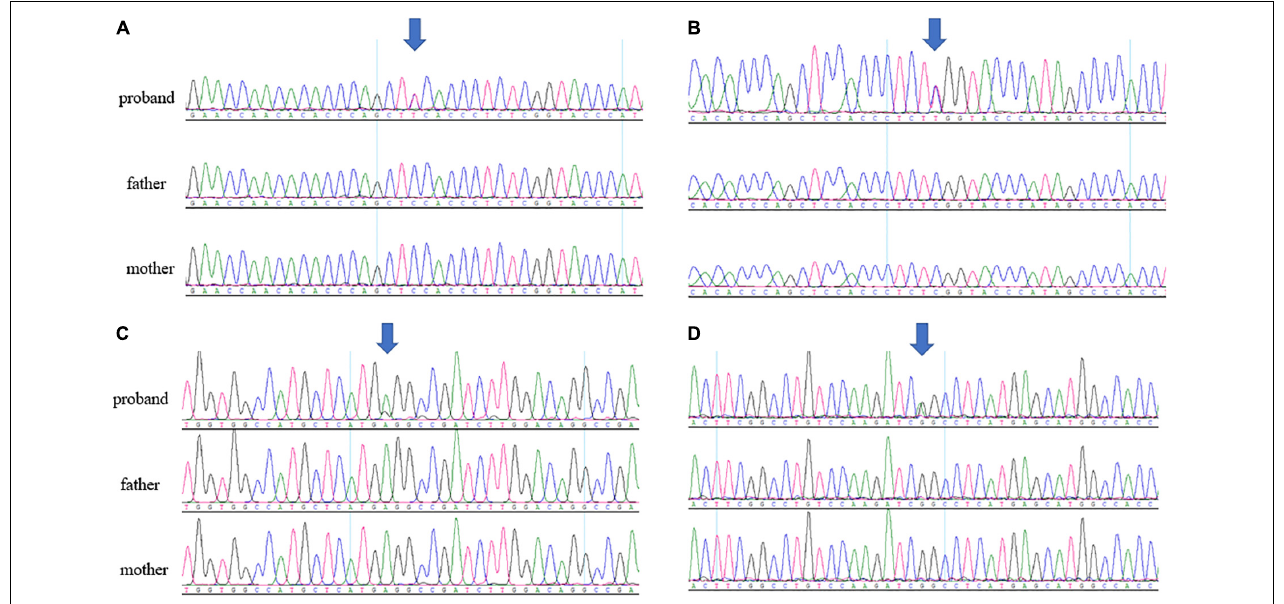
FIGURE 1 | (A) Sanger sequencing results of c.302C > T in patient 1 trio. (B) Sanger sequencing results of c.311C > T in patient 2 trio. (C) Sanger sequencing results of c.1547T > C in patient 3 trio. (D) Sanger sequencing results of c.1543G > A in patient 4 trio. The arrows pointed to the location of the variants.